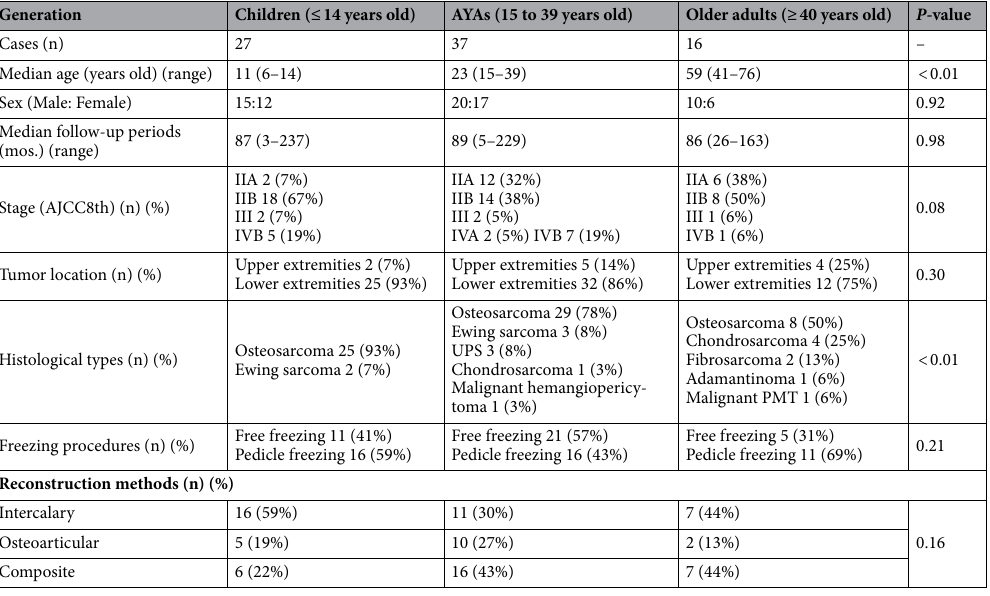
Table 1. The demographic data of the patients who underwent frozen autograft reconstruction on the appendicular skeleton in the three age groups. AJCC American Joint Committee on Cancer, UPS undifferentiated pleomorphic sarcoma, PMT phosphaturic mesenchymal tumor, mos